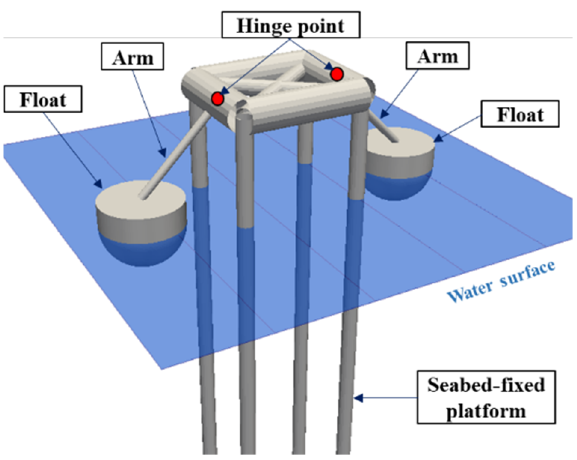
Figure 1. Description of a Wavestar-type WEC platform applied in this